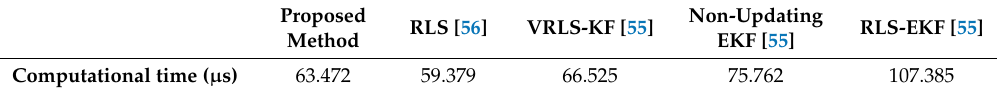
Table 3. Performance comparison of the proposed and other methodologies.